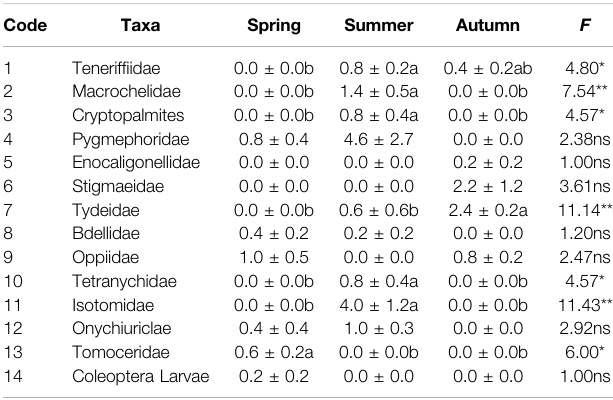
(cid:129) m − 2 ) of taxonomic groups